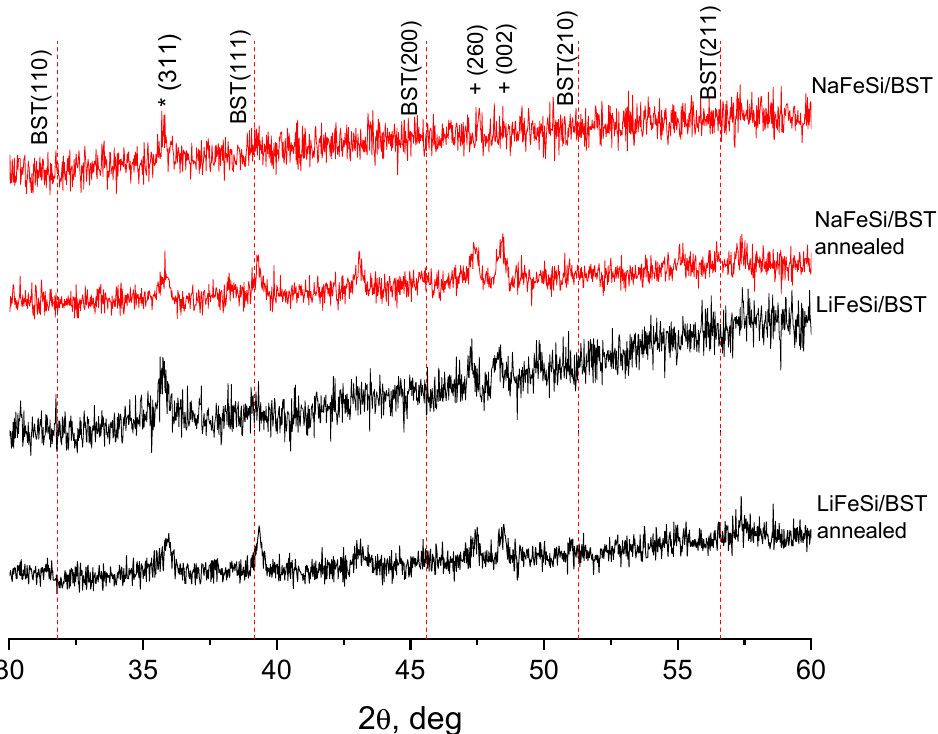
Figure 7. XRD of BaSrTiO 3 in porous glass matrices before and after annealing in oxygen atmosphere ( ∗ — γ -Fe 2 O 3 Pdf No 24-81 [24]; + —presumably BaTi 4 O 9 Pdf No 34-70 [24]).